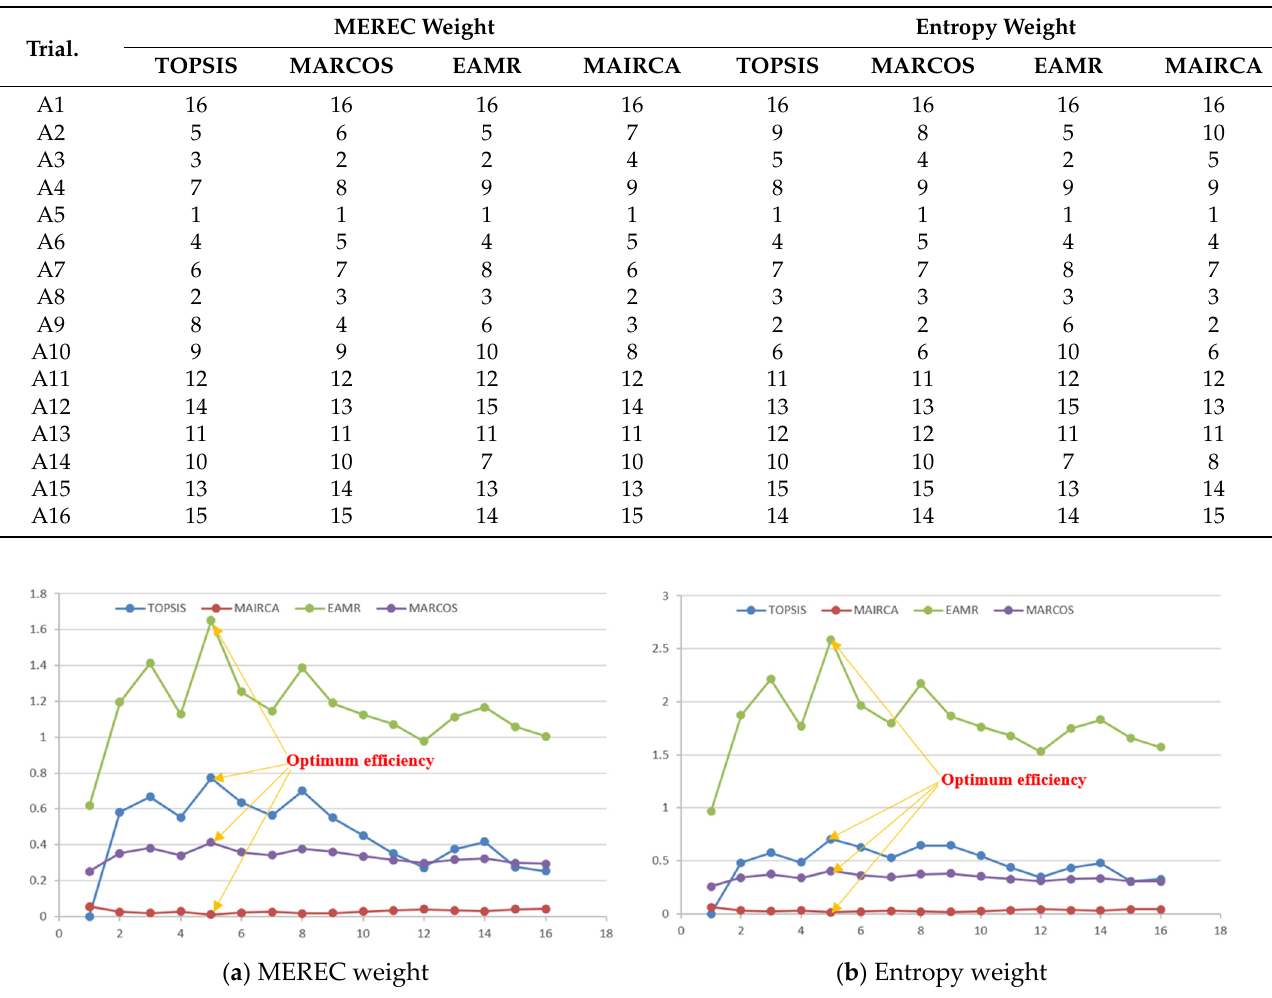
Table 9. Ranking or alternatives when using MEREC and the entropy method for weight calculation.